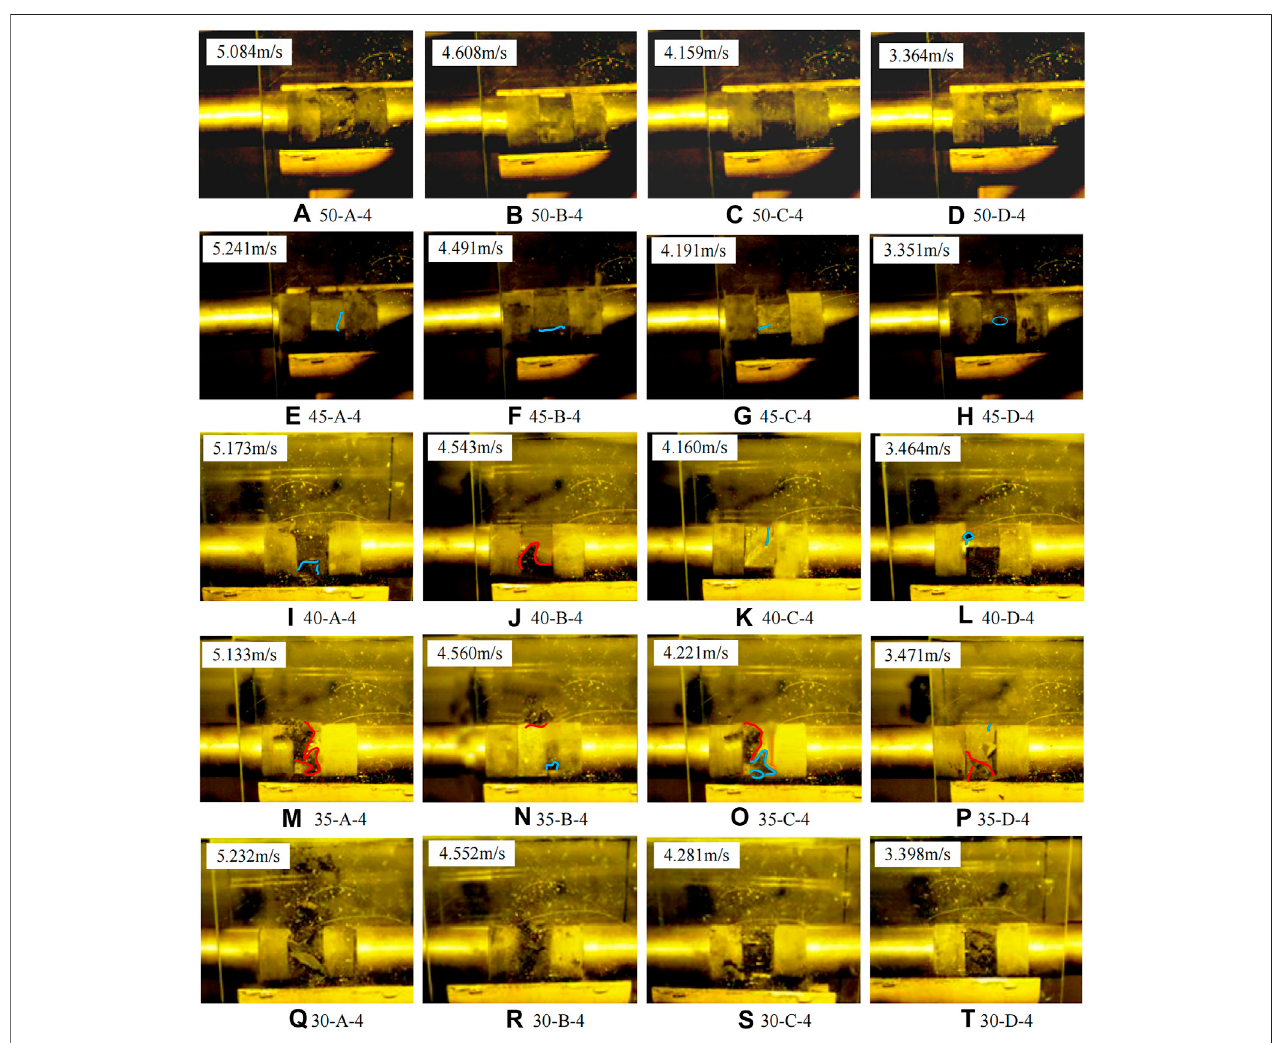
FIGURE 6 | (A – T) Failure patterns of specimens under different dynamic loads with 8 MPa pre-static load.